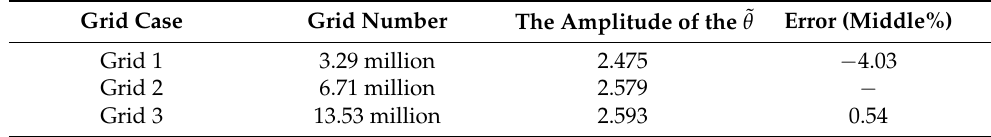
Table 4. Related parameters of three different